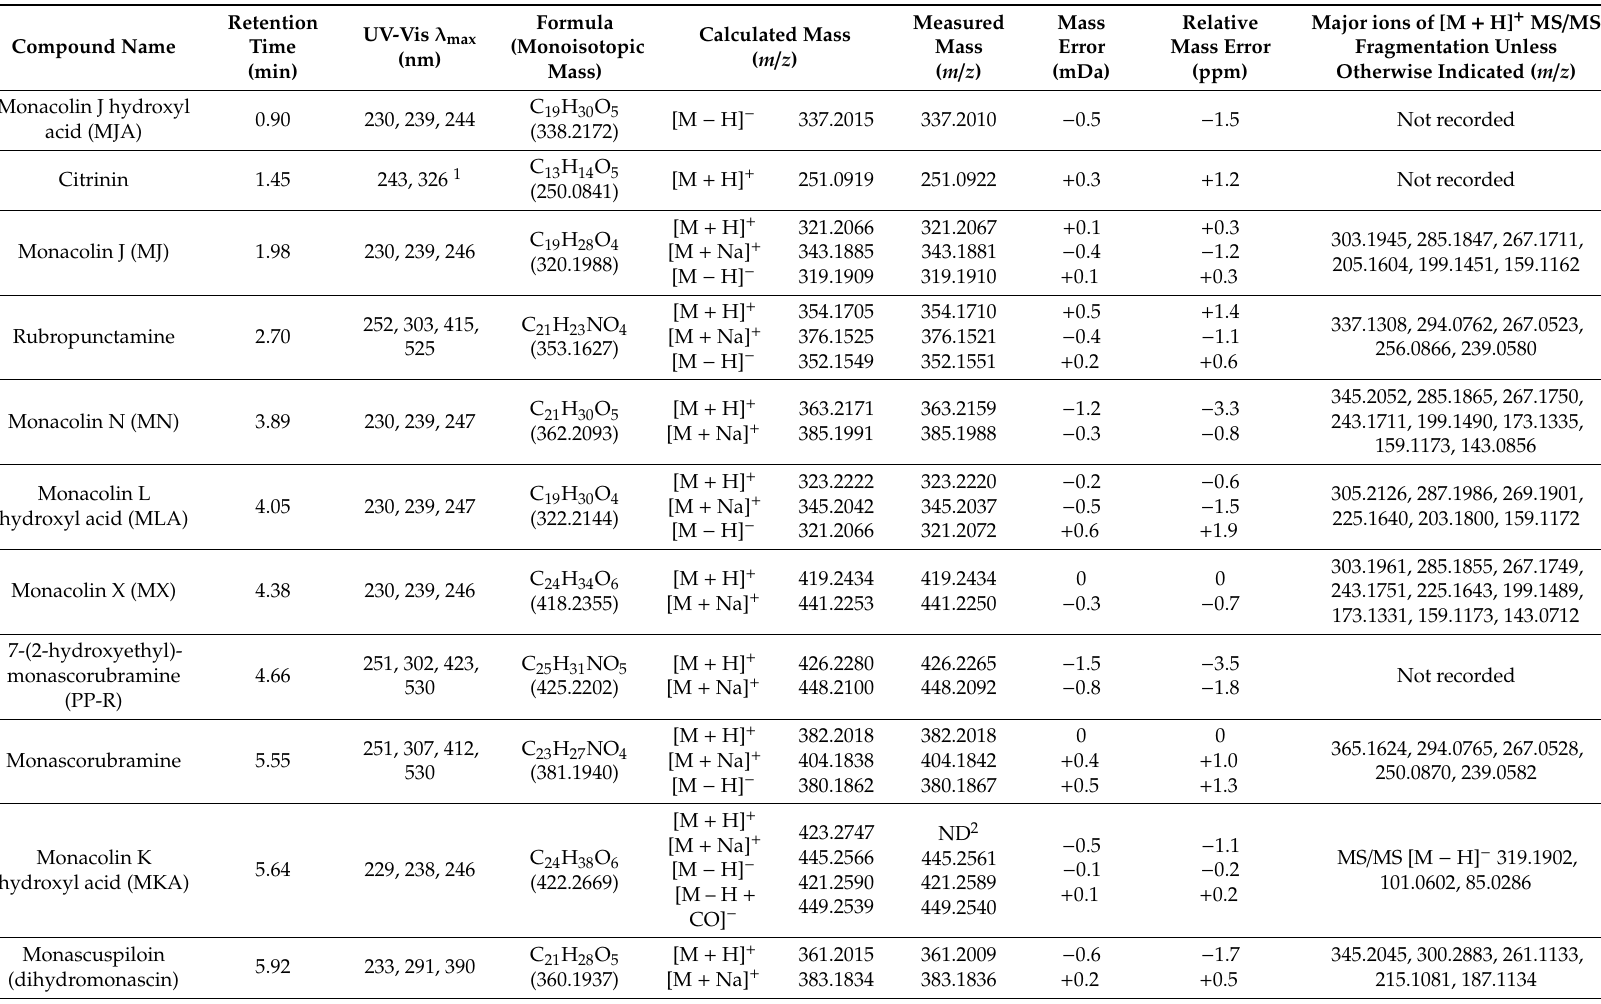
Table 4. Retention times, UV-Vis characteristics and accurate mass measurements of the compounds observed and identified from the RYR dietary supplements analyzed with